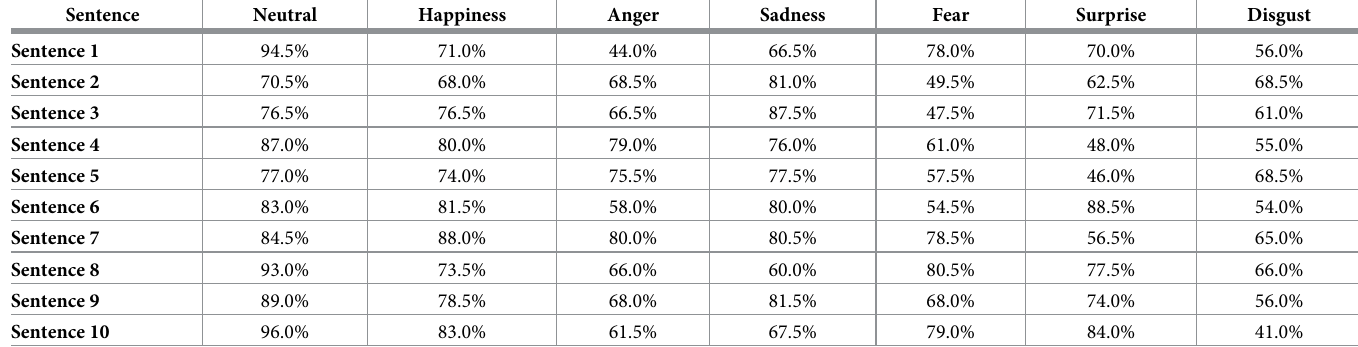
Table 6. Sentence-wise recognition rates for Phase 1.